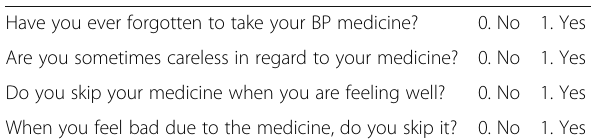
High adherence, if the sum = 0; medium adherence, if the sum is comprised between 1 and 2 and low adherence if the sum is comprised between 3 and